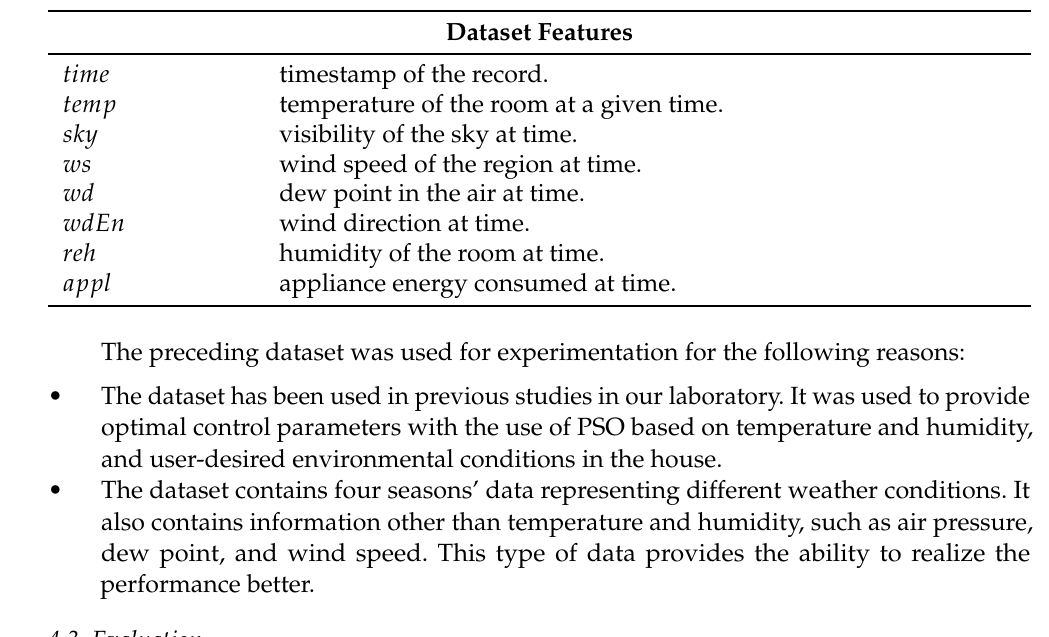
Table 6. Appliance energy dataset (South Korea) [12].